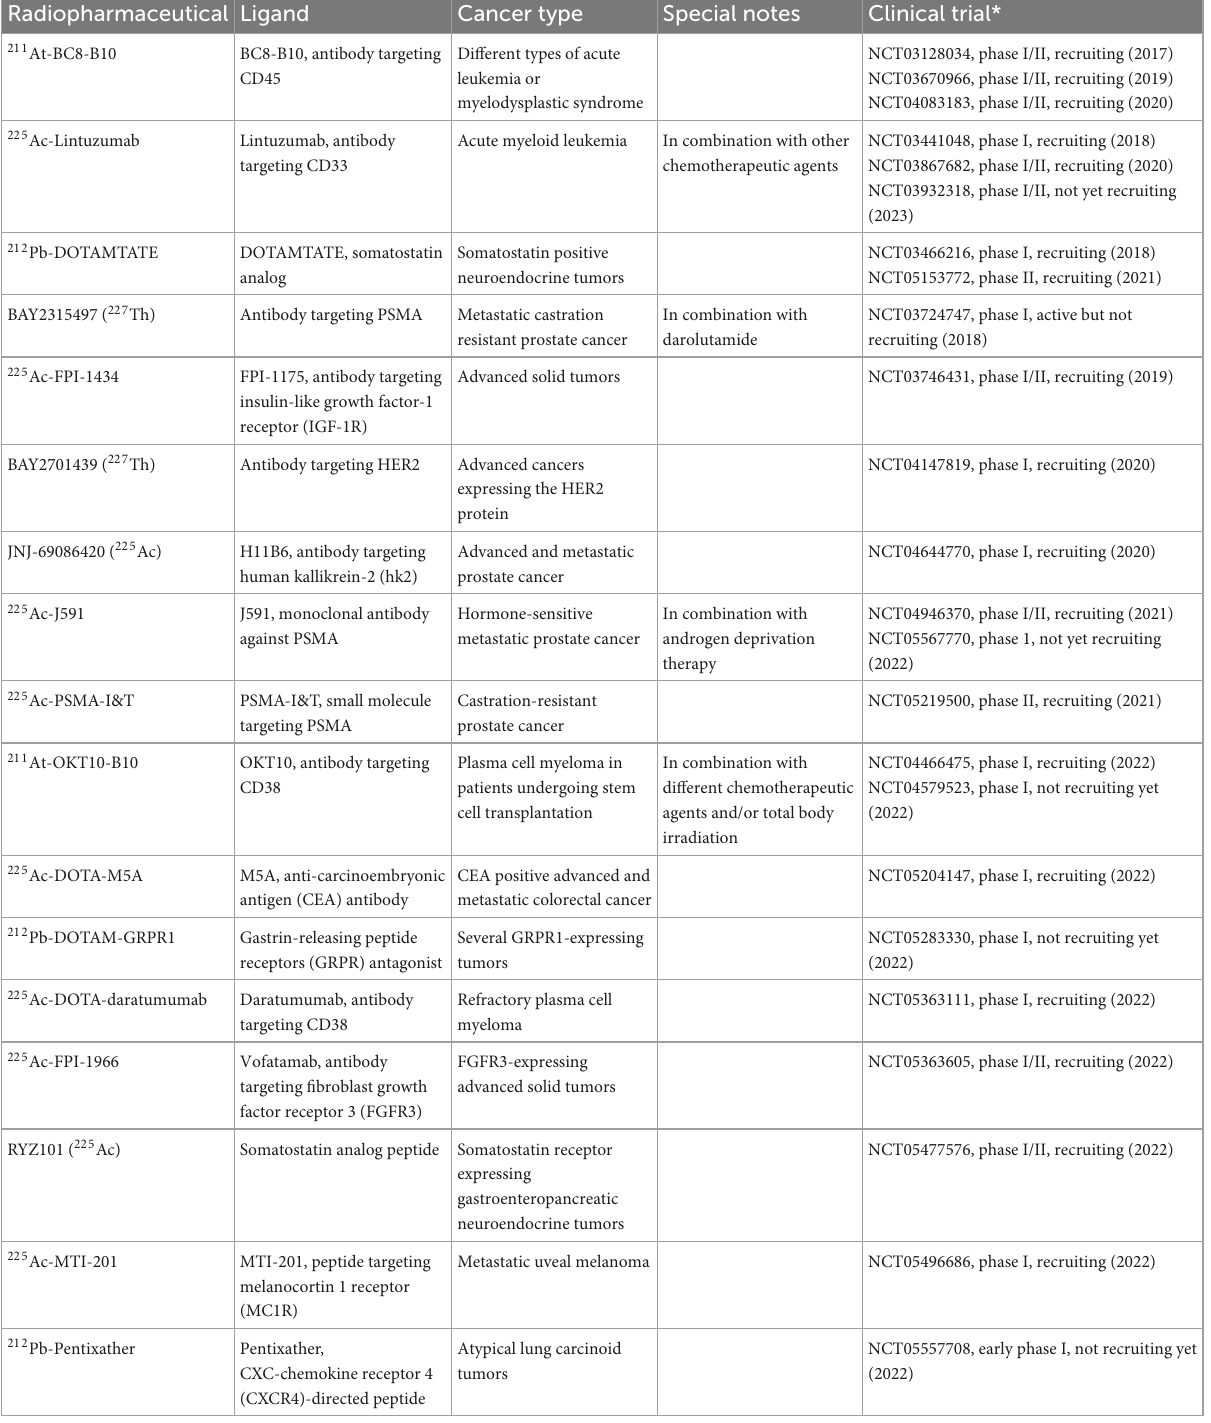
TABLE 1 Overview of ongoing targeted alpha therapy clinical